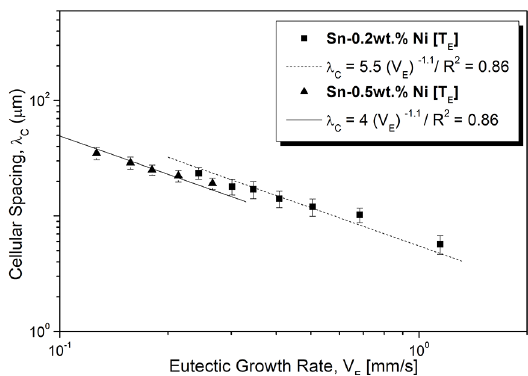
Figure 8. Experimental evolution of cellular spacing with the eutectic growth rate for the Sn-Ni alloys. R 2 is the coefficient of